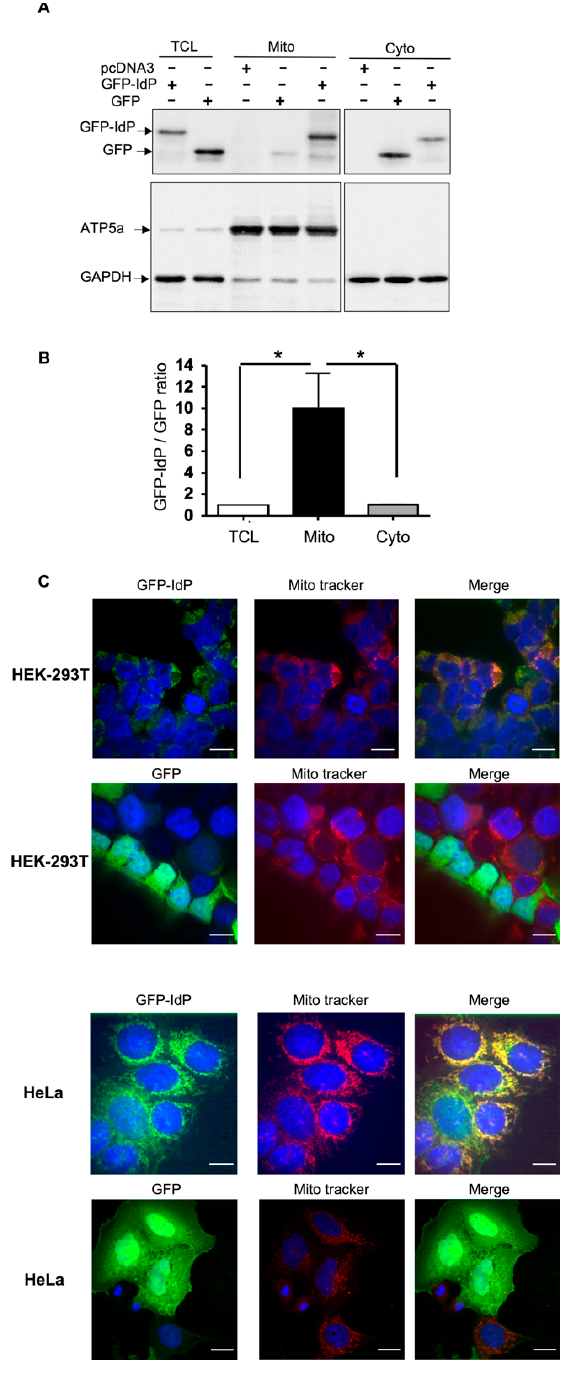
Figure 3. The intron-derived peptide of short OGA is sufficient to target GFP to the mitochondria. ( A ) HEK-293T cells were transfected with cDNA coding for either GFP or GFP fused at its C-terminus with OGA intron-derived peptide (GFP-IdP). Total cell lysate, mitochondrial-, and cytosol-enriched frac- tions were analyzed by Western blotting with anti-GFP antibody. GFP-IdP was more abundant in the mitochondrial-enriched fraction whereas GFP was more abundant in the cytosol-enriched fraction. ( B ) Densitometric analysis of the GFP and GFP-IdP bands. The results are the mean ± SEM of the ratio of the GFP-IdP to GFP signals detected in TCL, cytosol-, and mitochondria-enriched fractions ( n = 5; *: p < 0.05). ( C ) HEK-293T cells and HeLa cells were transfected with cDNA coding for GFP or GFP fused at its C-terminus with OGA intron-derived peptide (GFP-IdP), fixed, and labeled with mitotracker. Confocal microscopy experiments confirmed co-localization of GFP-IdP with mitotracker. GFP alone was widely distributed into the cells, including the nucleus.